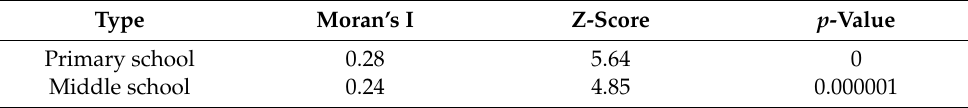
Table 2. The results of global spatial autocorrelation.